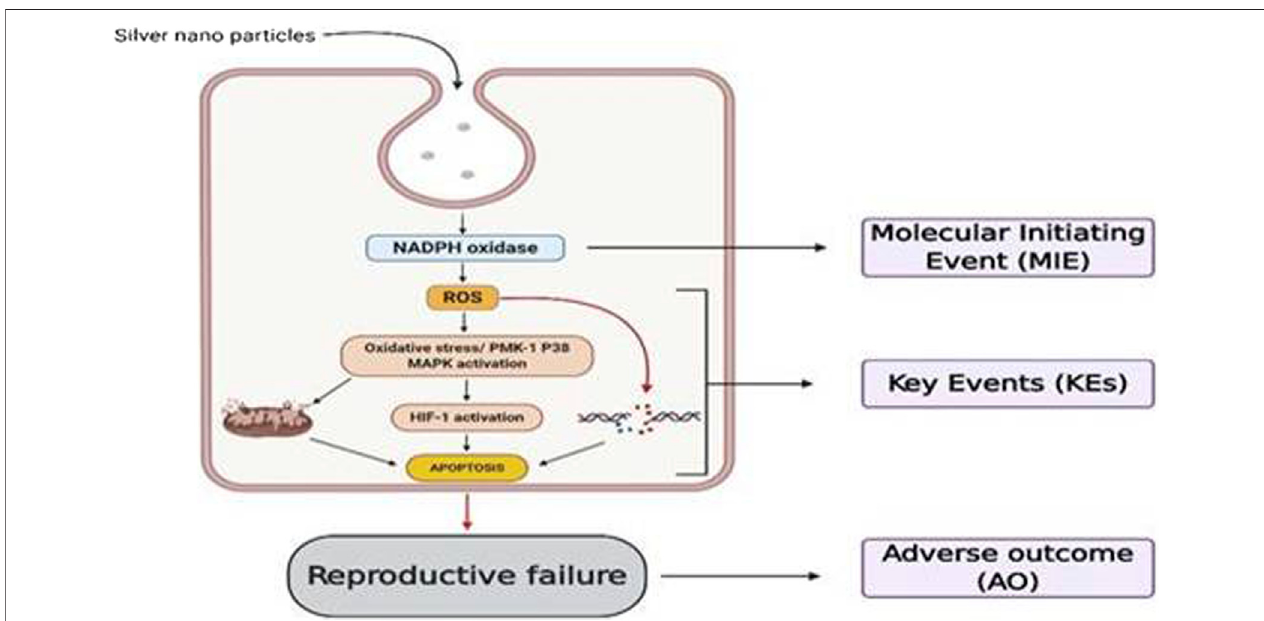
FIGURE 7 | Illustration of the mechanistic pathway by which AgNPs will cause reproductive toxicity in C. elegans .